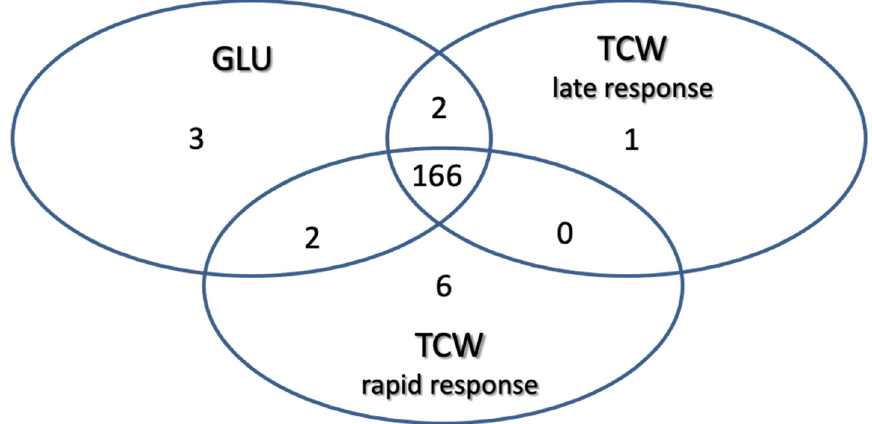
Figure 3. Classification of identified proteins as exclusive or overexpressed in each assayed condition and non-regulated proteins common to two or three conditions.